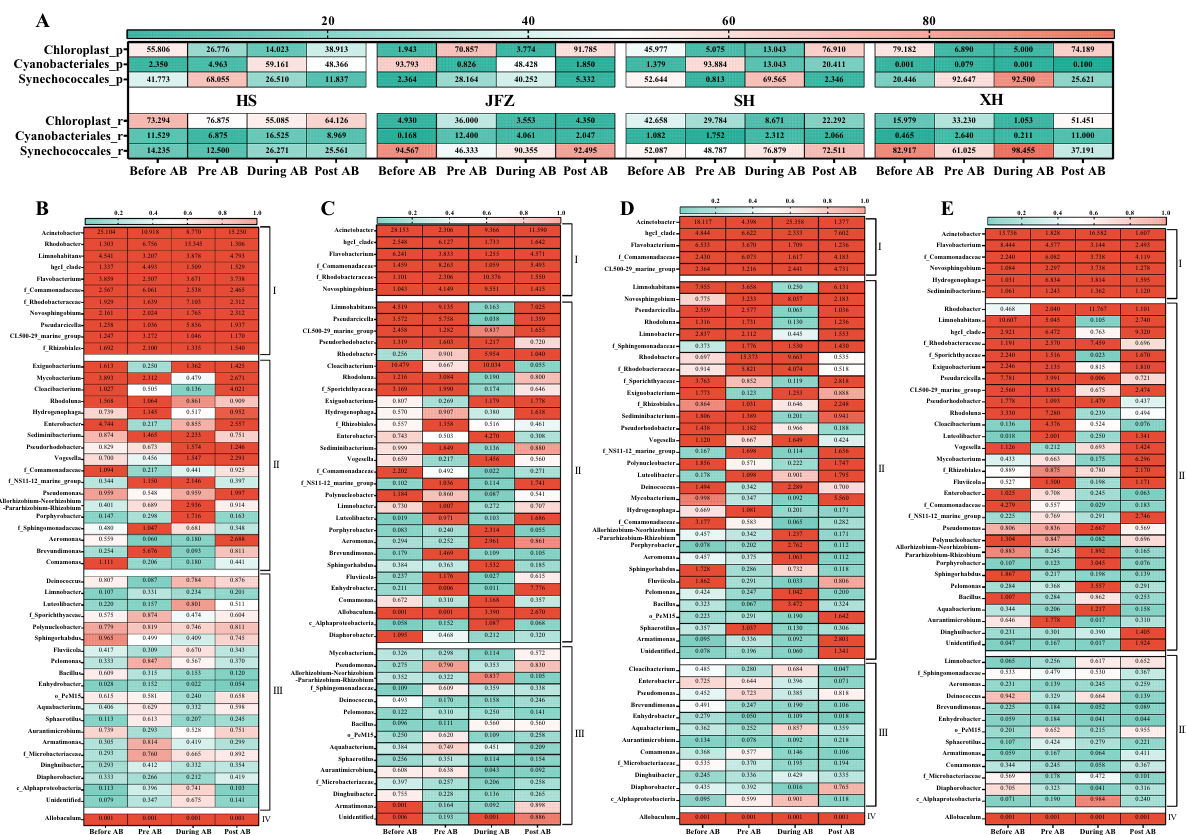
Figure 3. Dynamics of dominant cyanobacterial and bacterial taxa along with the cyanobacterial bloom. ( A ) Dominant cyanobacteria at order level in each tributary pool (_p) and rivers (_r). ( B – E ) Top 50 dominant bacterial genus in HS, JFZ, SH, and XH, respectively. Digits in boxes represented the relative abundances of cyanobacterial and bacterial taxa, and the group I-IV stood for always abundant taxa (AAT), conditionally varied taxa (CVT), always moderate taxa (AMT), and always rare taxa (ART), respectively. Bacterial taxa that categorized as “abundant” (> 1%) and “rare” (< 0.01) were shown in unified